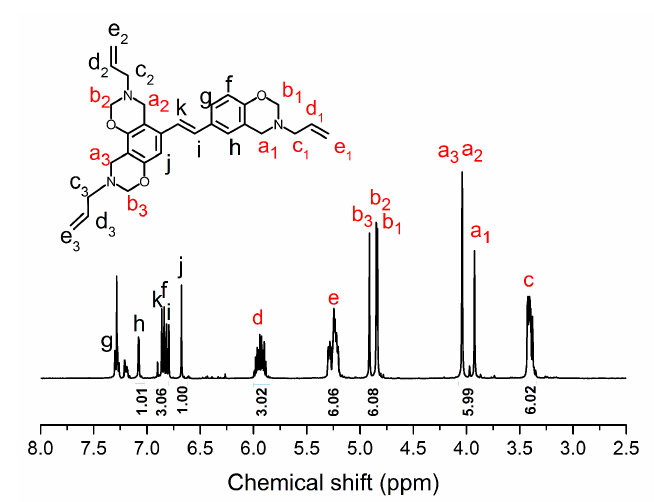
Figure 1. 1 H NMR spectrum of RES-al in CDCl 3 .